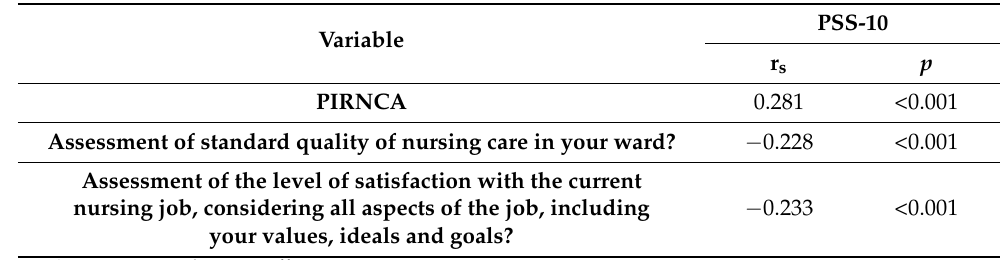
Table 3. Results of the correlation analysis of the perceived stress among the nurses participating in the study and rationing of nursing care.